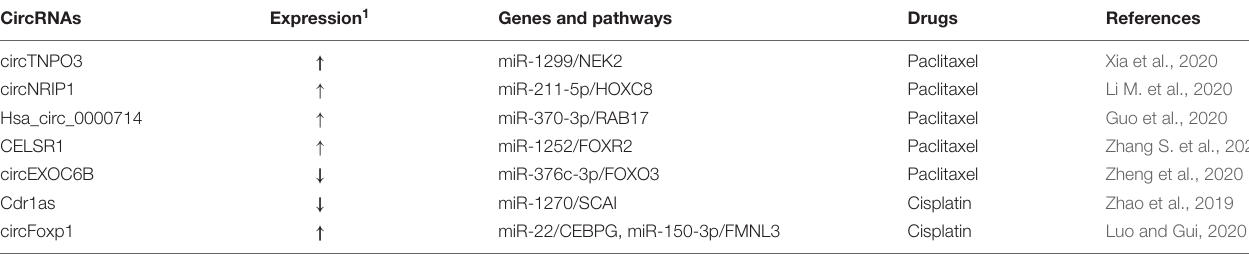
TABLE 6 | CircRNAs and drug resistance in ovarian